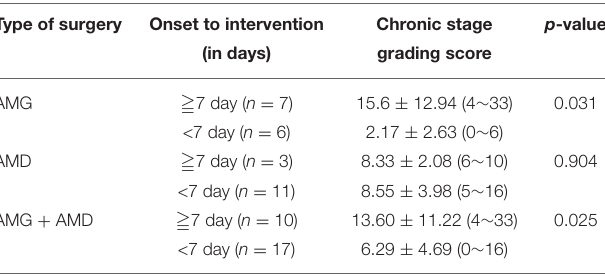
TABLE 5B | Comparison of Sotozono’s chronic stage grading score in patients receiving AM transplantation more than or < 7 days after onset. Type of